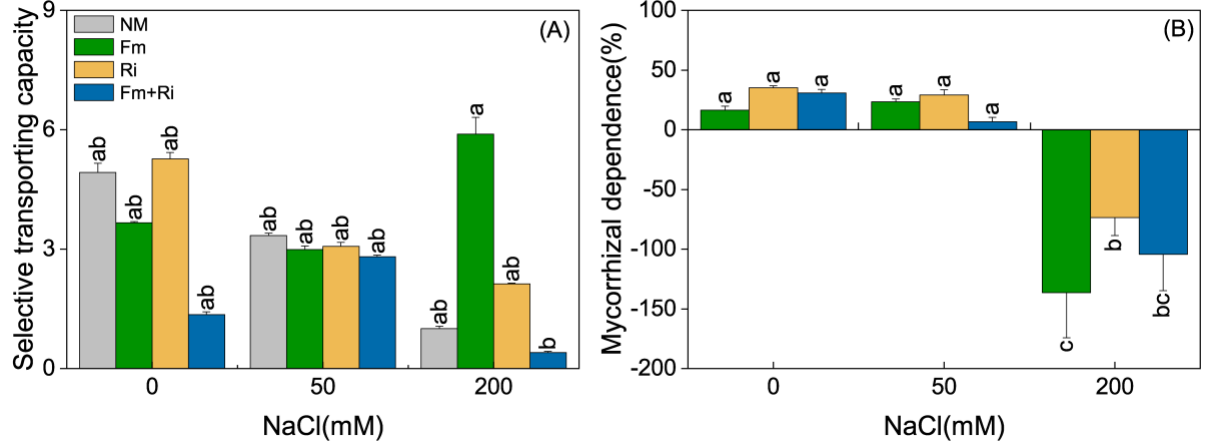
Figure 4. Effects of arbuscular mycorrhizal fungi on selective transporting capacity ( STC ) ( A ) and mycorrhizal dependence ( MD ) ( B ) of Cinnamomum camphora plants under 0, 50, and 200 mM NaCl. NM, Fm, Ri, and Fm+Ri represent the four mycorrhizal treatments: inoculation with sterilized mycorrhizal fungi, with Funneliformis mosseae or Rhizophagus irregularis, either alone or in combination, respectively. Values for STC are presented as the mean ± SE ( n = 3), and those for MD are stated as the mean ± SE ( n = 6). Different lowercase letters indicate a significant difference according to LSD at p < 0.05.